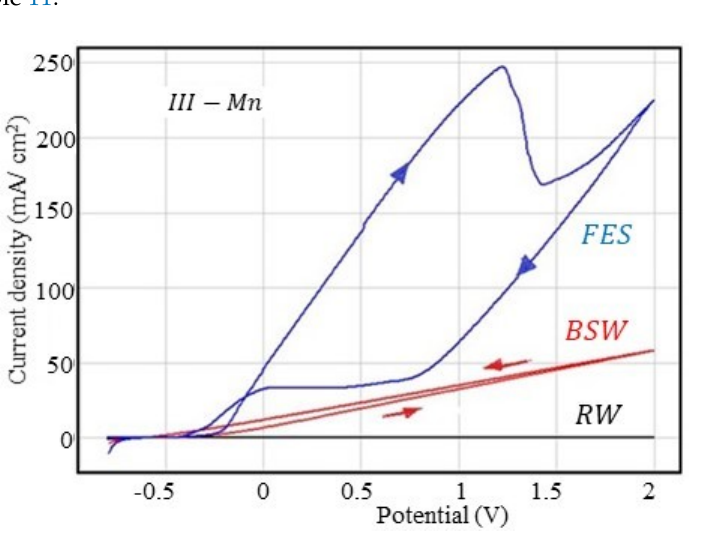
Table 12. Comparison between corrosion rates (v cor -in µm/year) for the III-Mn sample. Corrosive Environment